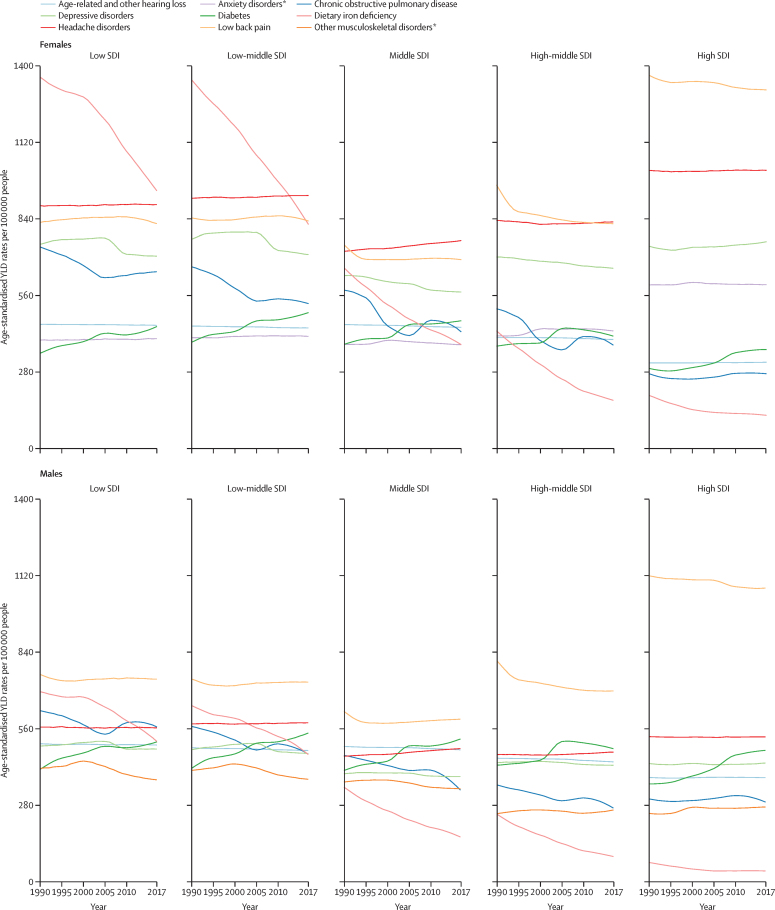
Trends of age-standardised YLD rates per 100 000 for the top eight Level 3 causes of non-fatal burden in 2017 for each sex by SDI quintile, 1990–2017Mean estimates are shown. SDI=Socio-demographic Index. YLDs=years lived with disability. *One legend is shown for females and males. Anxiety disorders are a top cause of non-fatal burden for females and other musculoskeletal disorders are a top cause of non-fatal burden for males.